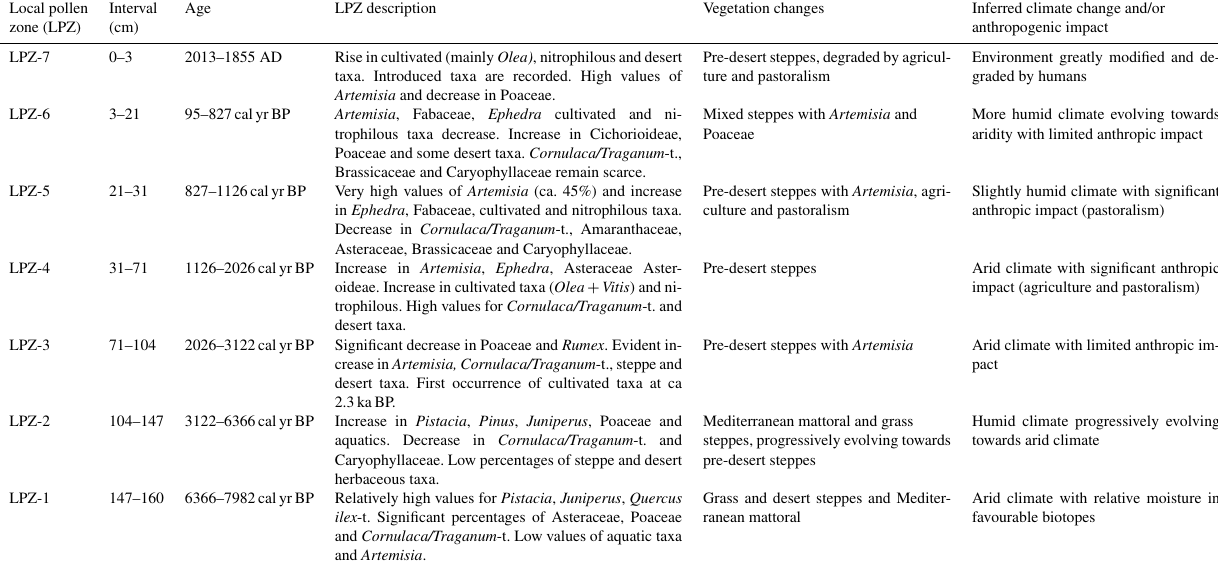
Figure 3. Pollen percentage diagram from Sebkha Boujmel showing the evolution of the main pollen taxa of the three ecological groups (Mediterranean, steppe and desert taxa) plotted against age. Pollen taxa and types from the same genus or family and with the same ecology are grouped on the pollen diagram, including Boraginaceae ( Moltkiopsis ciliata , Onosma and Echium ), Ephedra sp. ( Ephedra fragilis -t. and Ephedra distachia -t.) and Zygophyllaceae ( Fagonia , Nitraria and Zygophyllum ). Percentage of aquatics pollen are calculated based on the total sum of pollen grains identified in each pollen spectrum. Black boxes on the depth scale indicate positions of 14 C AMS dates. Table 2. Local pollen zones, vegetation, and inferred climatic and/or anthropogenic changes based on the pollen record from core BJM2. Local pollen Interval Age LPZ